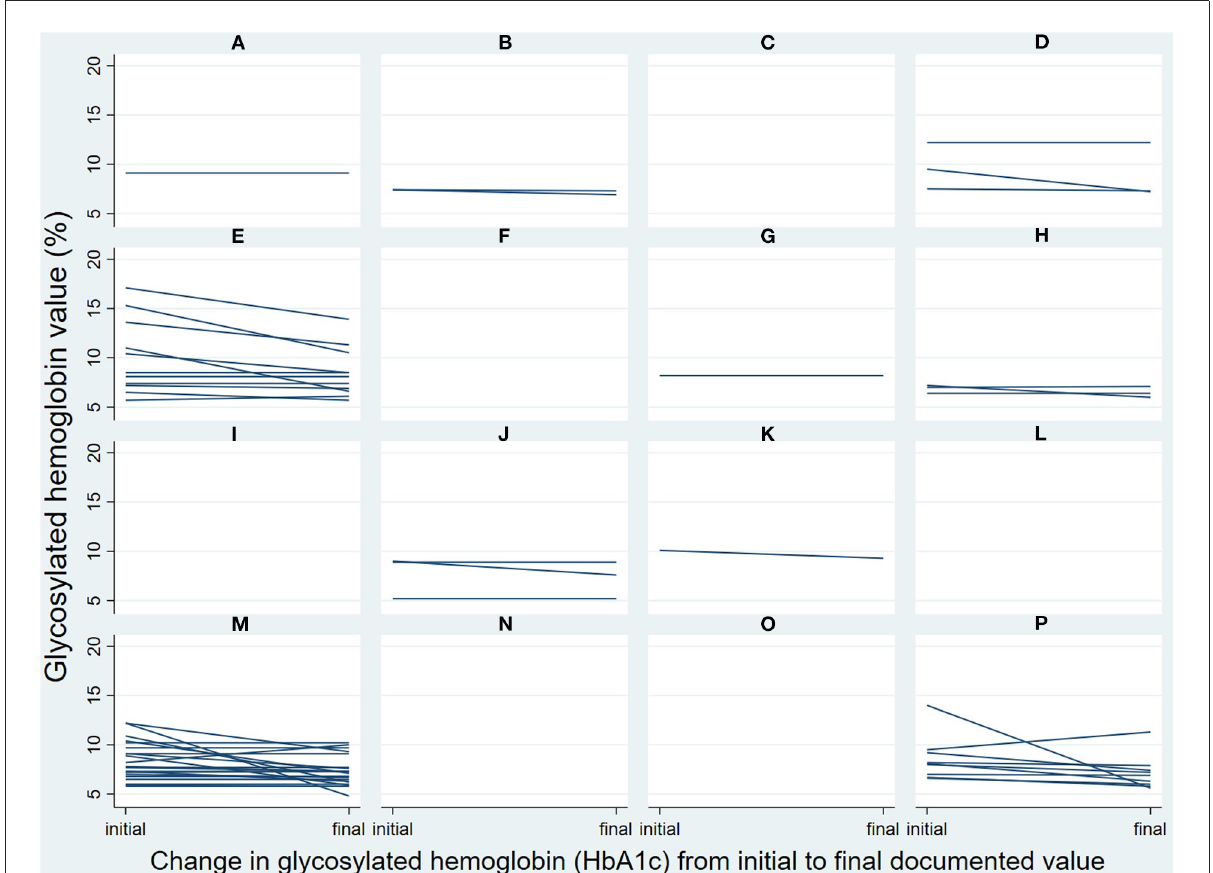
FIGURE1 Changes in patients’ glycosylated hemoglobin from initial to final documented value, by registered dietitian nutritionists [RDNs] (panels (A–P) each represent one RDN) and patient (each individual line) as documented during the Diabetes Registry Study ( n = 56). Patients had two or more documented RDN encounters, with most having two total encounters ( n = 36; 64%) and the rest having 3–4 total encounters ( n = 15; 27%) or 5–8 total encounters ( n = 5;